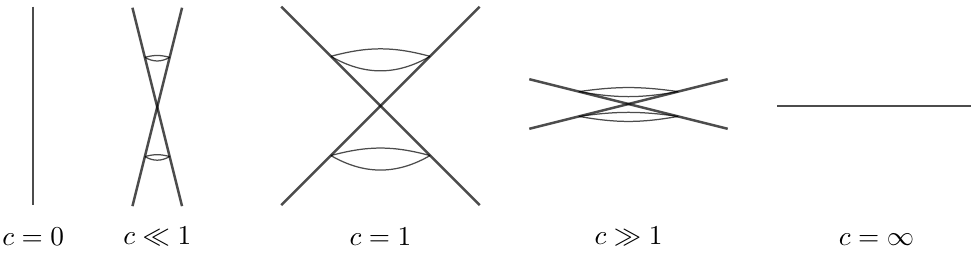
Figure 1 . E(cid:11)ect on light cone of ultra- (left) and non-relativistic (right)